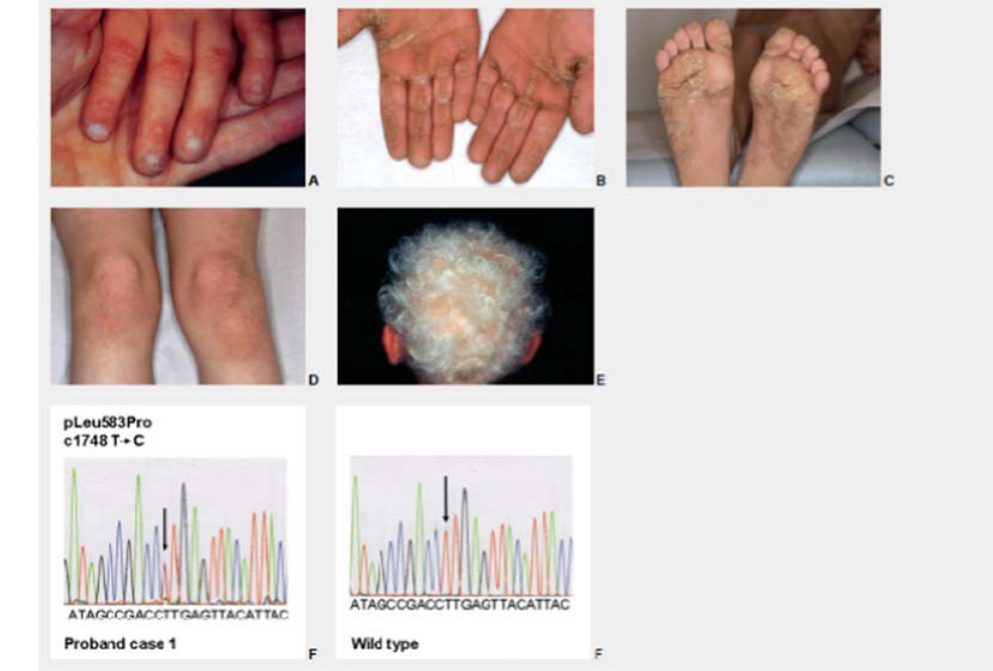
Figure 4. Deramological phenotype and genetic screening of a case of Cardiocutaenous syndrome (Carvajal). A: Dystrophic nail plates. B: Striate keratoderma of the palms. C: Plantar keratoderma, C: Erythemato-squamous skin lesions of the knee. E: curly wooly hair. F: Electropherograms of the desmoplakin mutation and of the wild type: a heterozygous variant in DSP , c.1748 T . C, was identified, resulting in the missense mutation p.Leu583Pro at a heterozygous state. From: Keller, D. et al. De novo heterozygous desmoplakin mutations leading to Naxos-Carvajal disease. Swiss medical weekly 142,